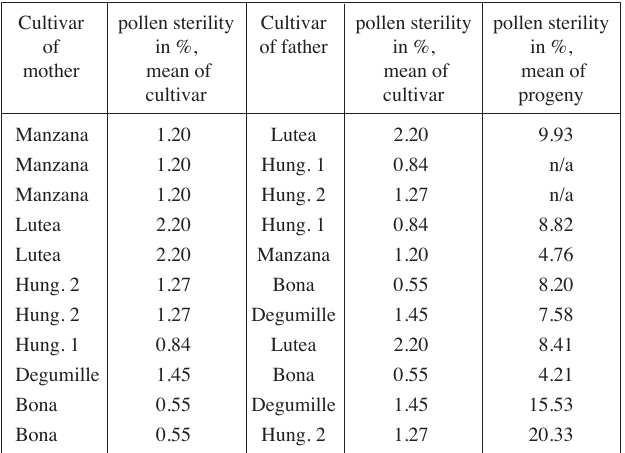
Tab. 3: Detailed percentages of pollen sterility of parental cultivars and their progeny, respectively